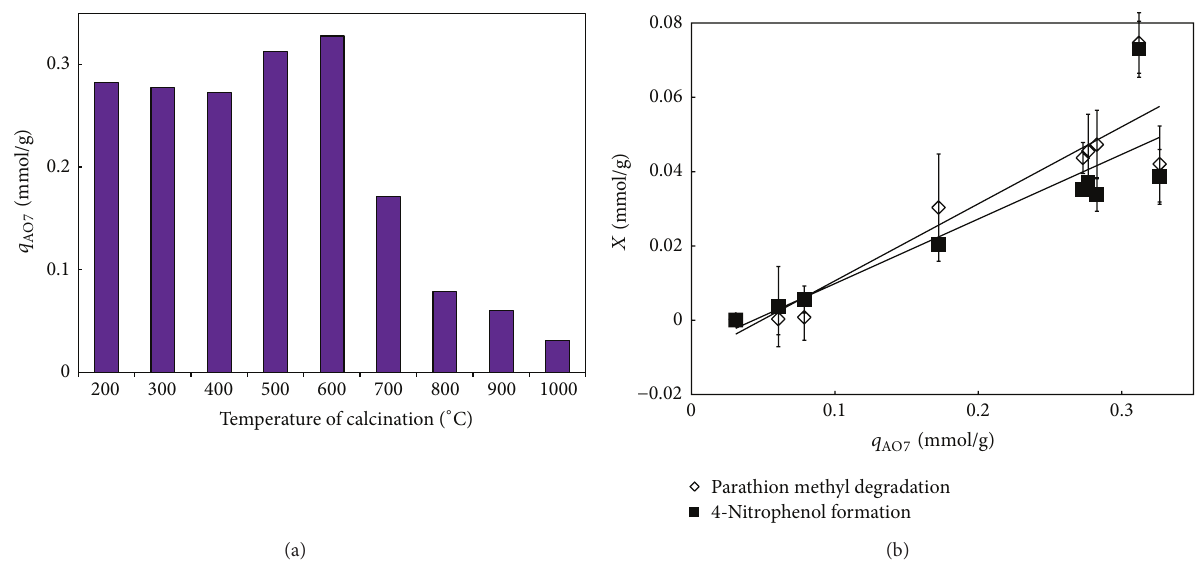
Figure 7: (a) Dependence of the sorption efficiency of CeO 2 on the calcination temperature. (b) Correlation between sorption efficiency towards AO7 and degradation efficiency towards parathion methyl (data from [17]). Degradation efficiency expressed i terms of parathion disappearance (open diamonds) and formation of 4-nitrophenol (black squares) as the main degradation product.